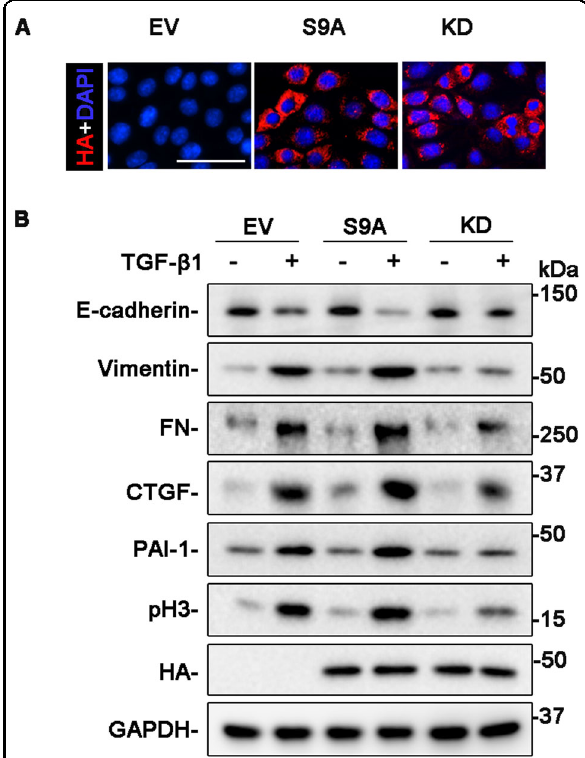
Fig. 4 The permissive effect of GSK3 β on the TGF- β 1 induced TEC pro fi brogenic plasticity. TKPT were subjected to liposome-mediated transiently transfection with vectors encoding the empty vector (EV), dominant-negative (KD), or constitutively active (S9A) GSK3 β . A Representative micrographs of fl uorescent immunocytochemistry staining for HA (red) with nuclear counterstaining with DAPI (blue). Scale bar = 50 μ m. B After transfection, cells were treated with 2 ng/ ml of TGF- β 1 for 24 h. Cell lysates were collected and subjected